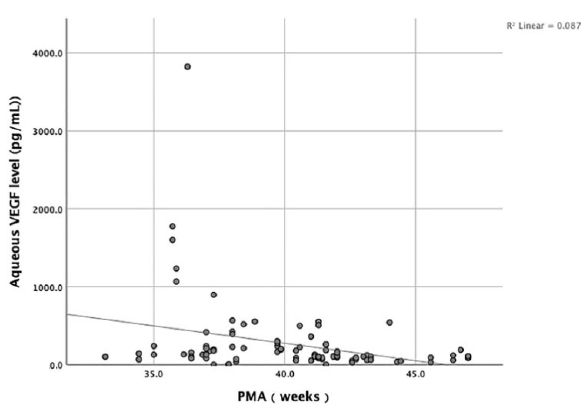
Figure 2. Scatterplot showing the negative correlation between the PMA and the aqueous VEGF level. According to the multiple linear regression analysis, the zone of ROP lesions, the stage of ROP lesions, and the grade of venous tortuosity in zone I significantly affected the aqueous VEGF level. The variable that most positively affected the aqueous